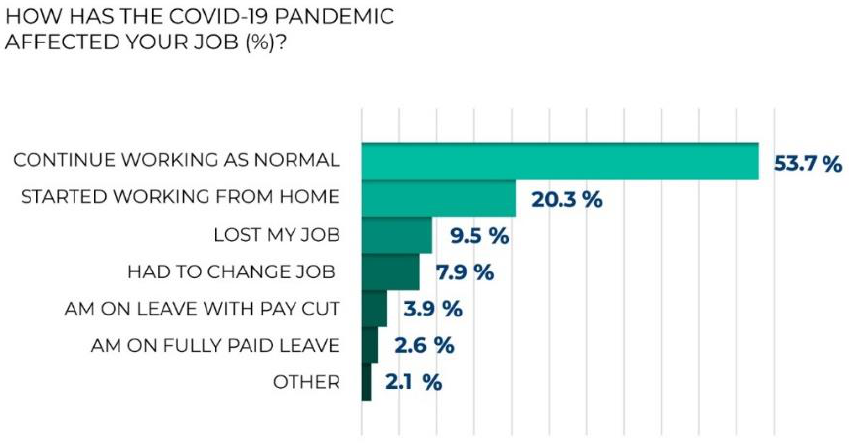
Figure 16. The results of the poll: How has the COVID-19 pandemic affected your job (excluding unemployed respondents)?